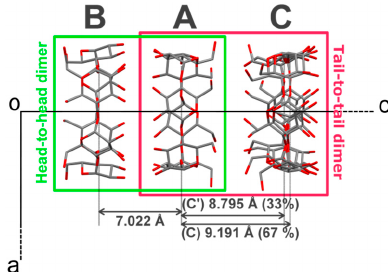
Figure 3. Projection of α -CD ∙ SA structure along the b -axis. The crystallographically-independent CD molecules are named A, B and C, see main text for details. H atoms, SA and water molecules have been omitted for clarity. The distances refer to gap in Å between the least-square planes formed by all O(4) atoms involved in the glycosidic bonds.